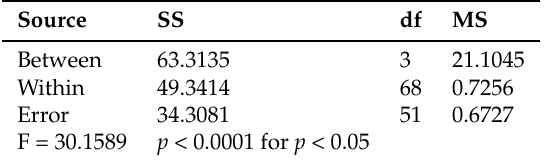
Table 10. One-way repeated ANOVA for P-score between male and female groups.